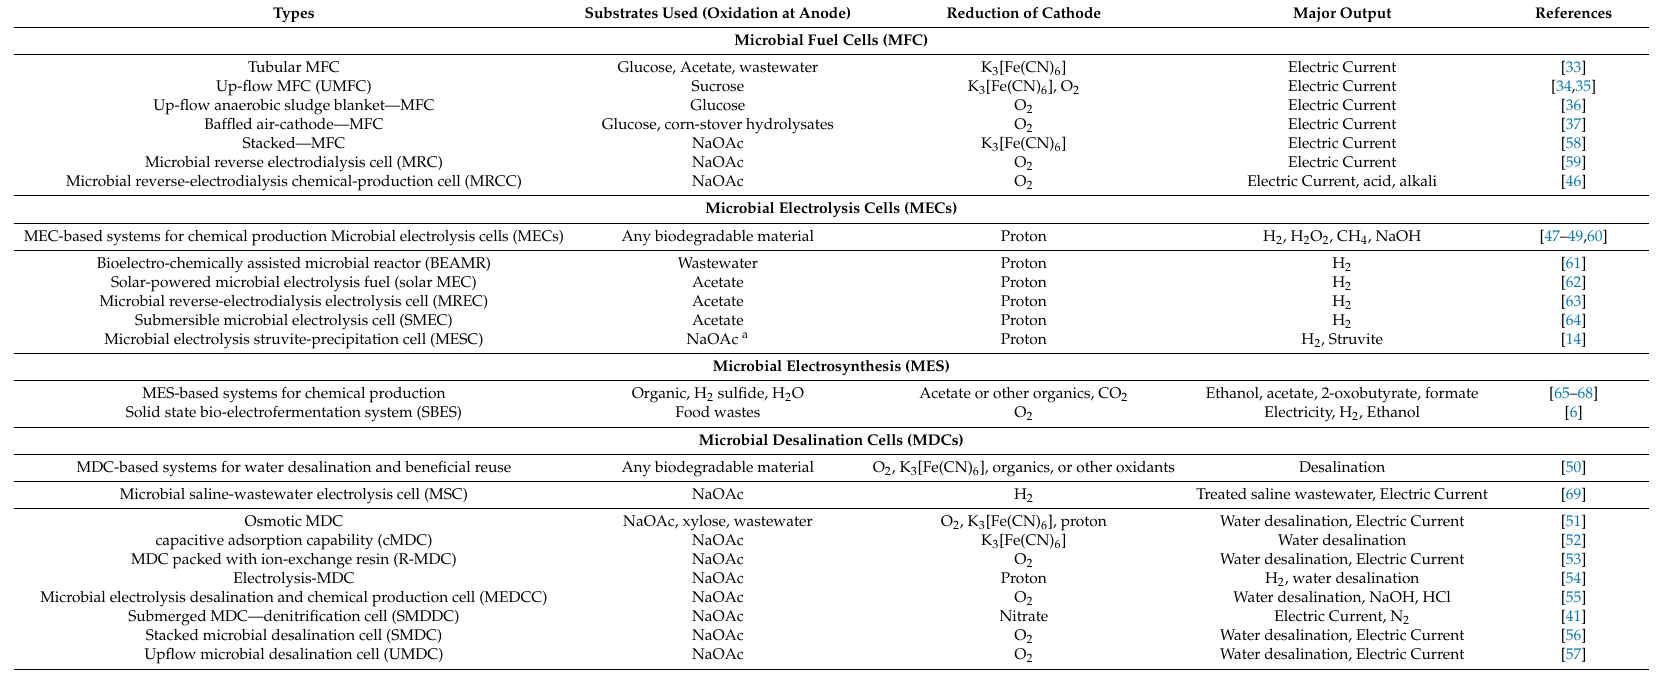
Table 1. Variants of electro-fermenters and their potential applications in aid of